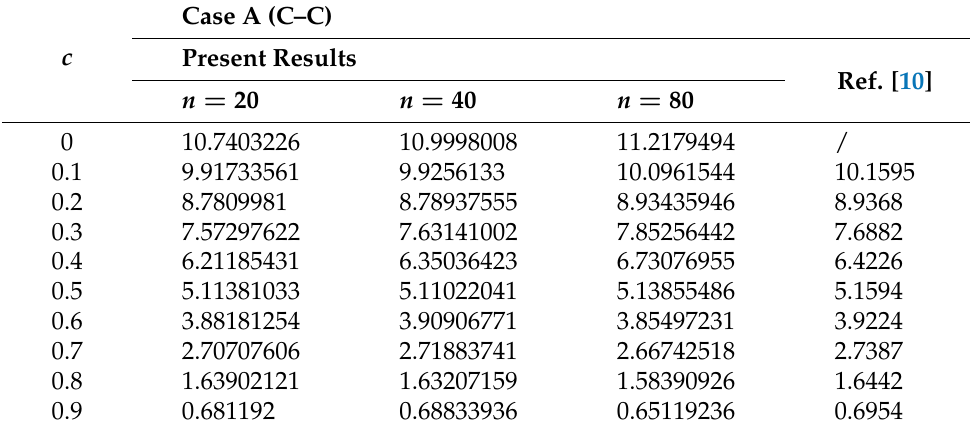
Table 3. Dimensionless critical load of a C–C axially FG Timoshenko beam with different taper coefficient ( m = 2).